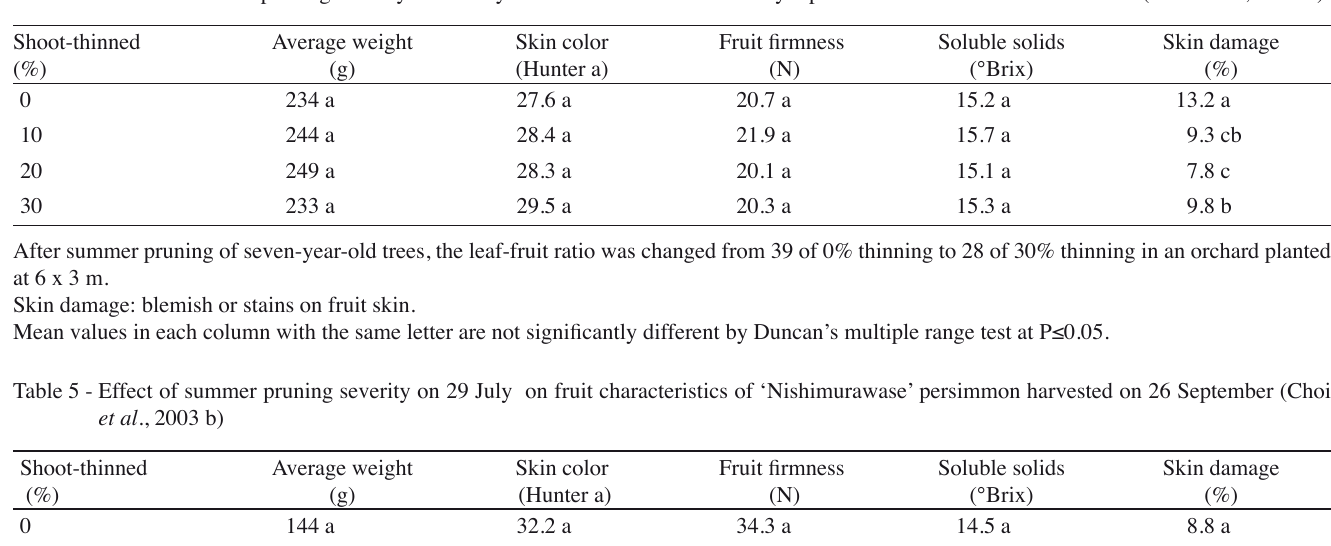
By summer pruning of 1-year-old trees, water sprouts were removed to maintain leaf-fruit ratio 20 in an orchard planted at 6 x 3 m. Table 4 - Effect of summer pruning severity on 28 July on fruit characteristics of ‘Fuyu’ persimmon harvested on 31 October (Choi et al ., 2003 b) Shoot-thinned (%)